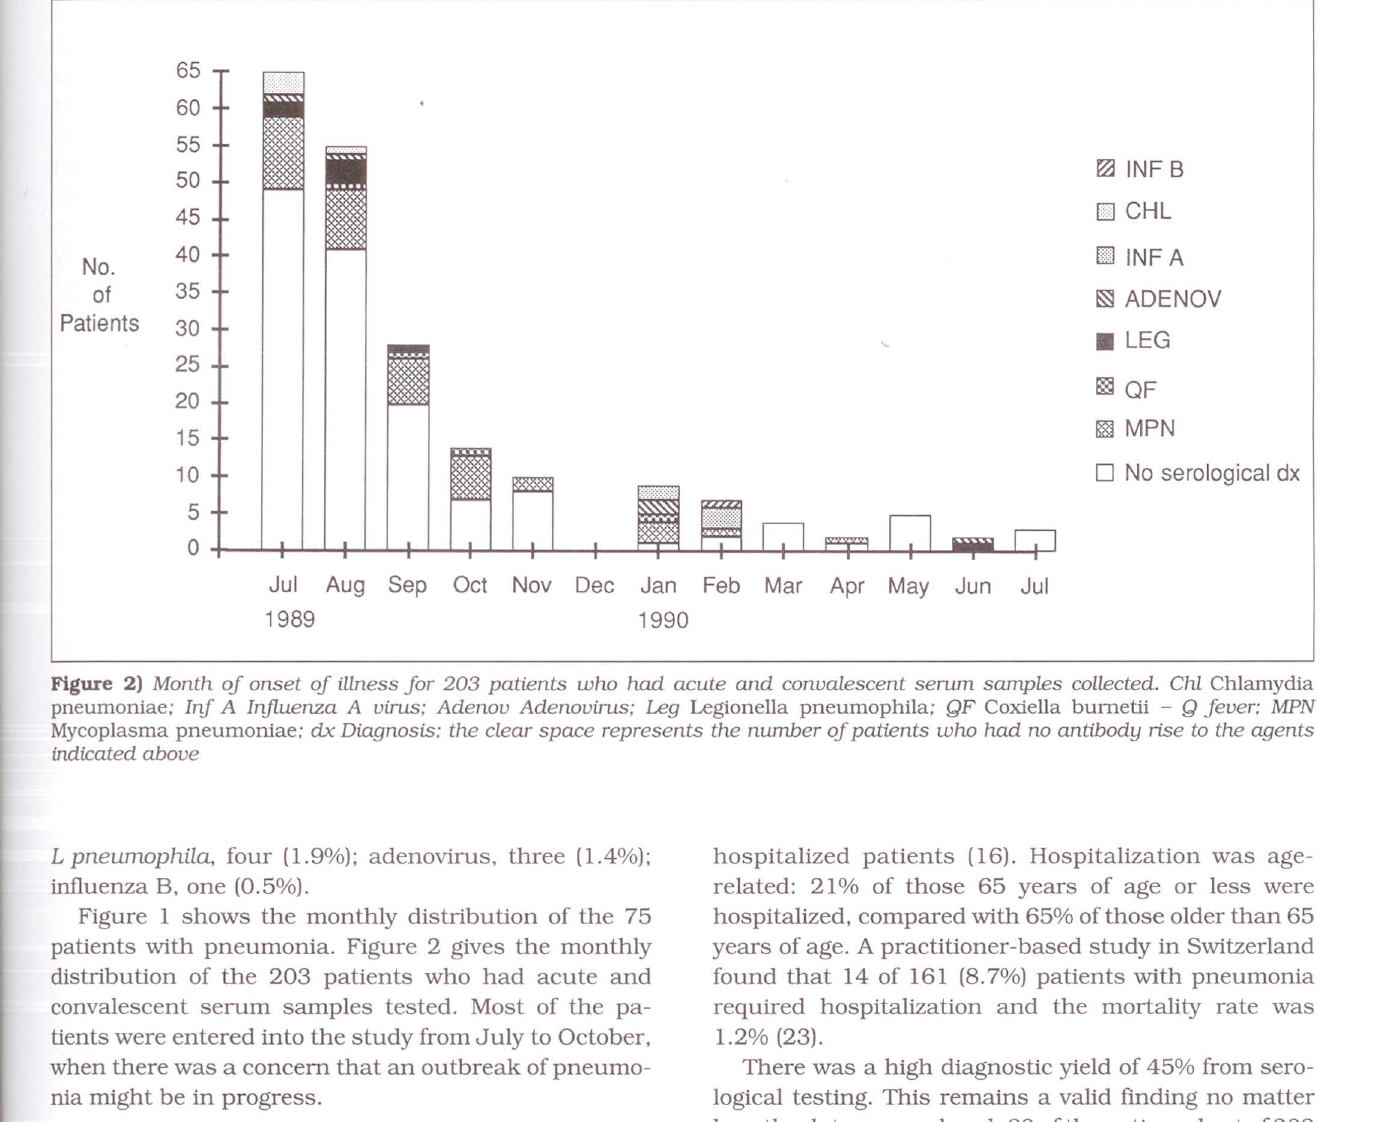
L pneumophila, four (1.9%); adenovirus, three (1.4%); influenza B, one